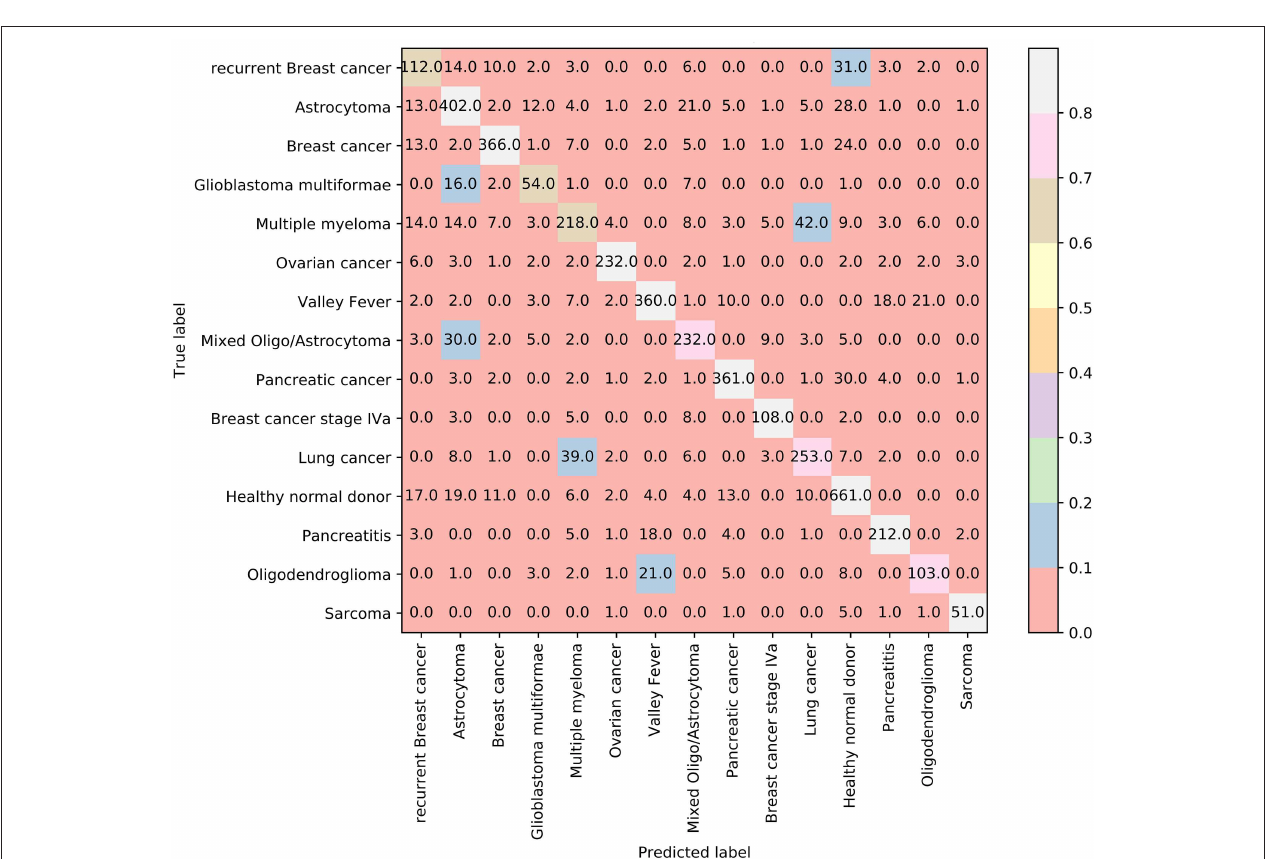
FIGURE 7 | The confusion map of 42 classification rules on dataset-2.